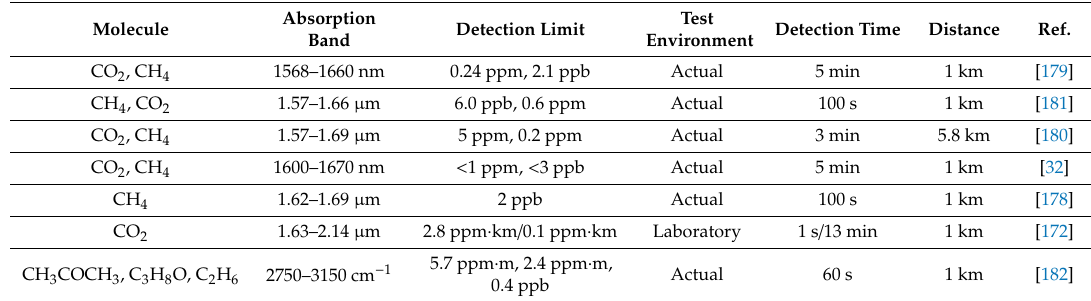
Table5. Performance of reported dual-comb spectroscopy (DCS) stando ff detection for